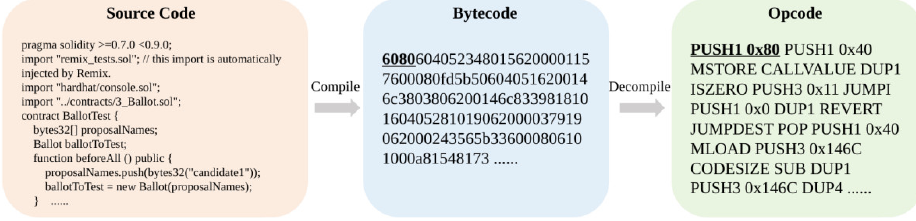
Figure 1. Source code, Bytecode, Opcode conversion relationship.